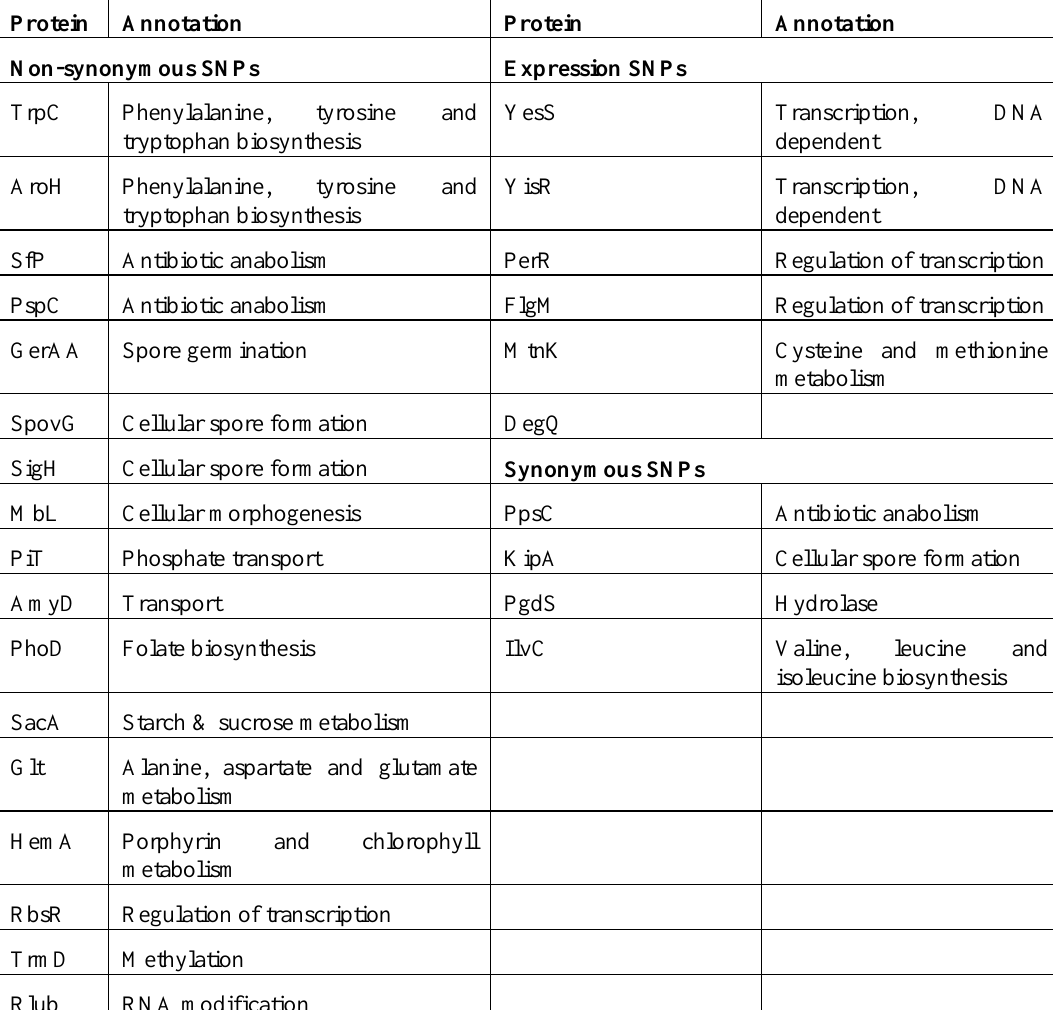
Table 2: SNPs Identified in B. subtilis 168 compared with the parent Marburg strain.